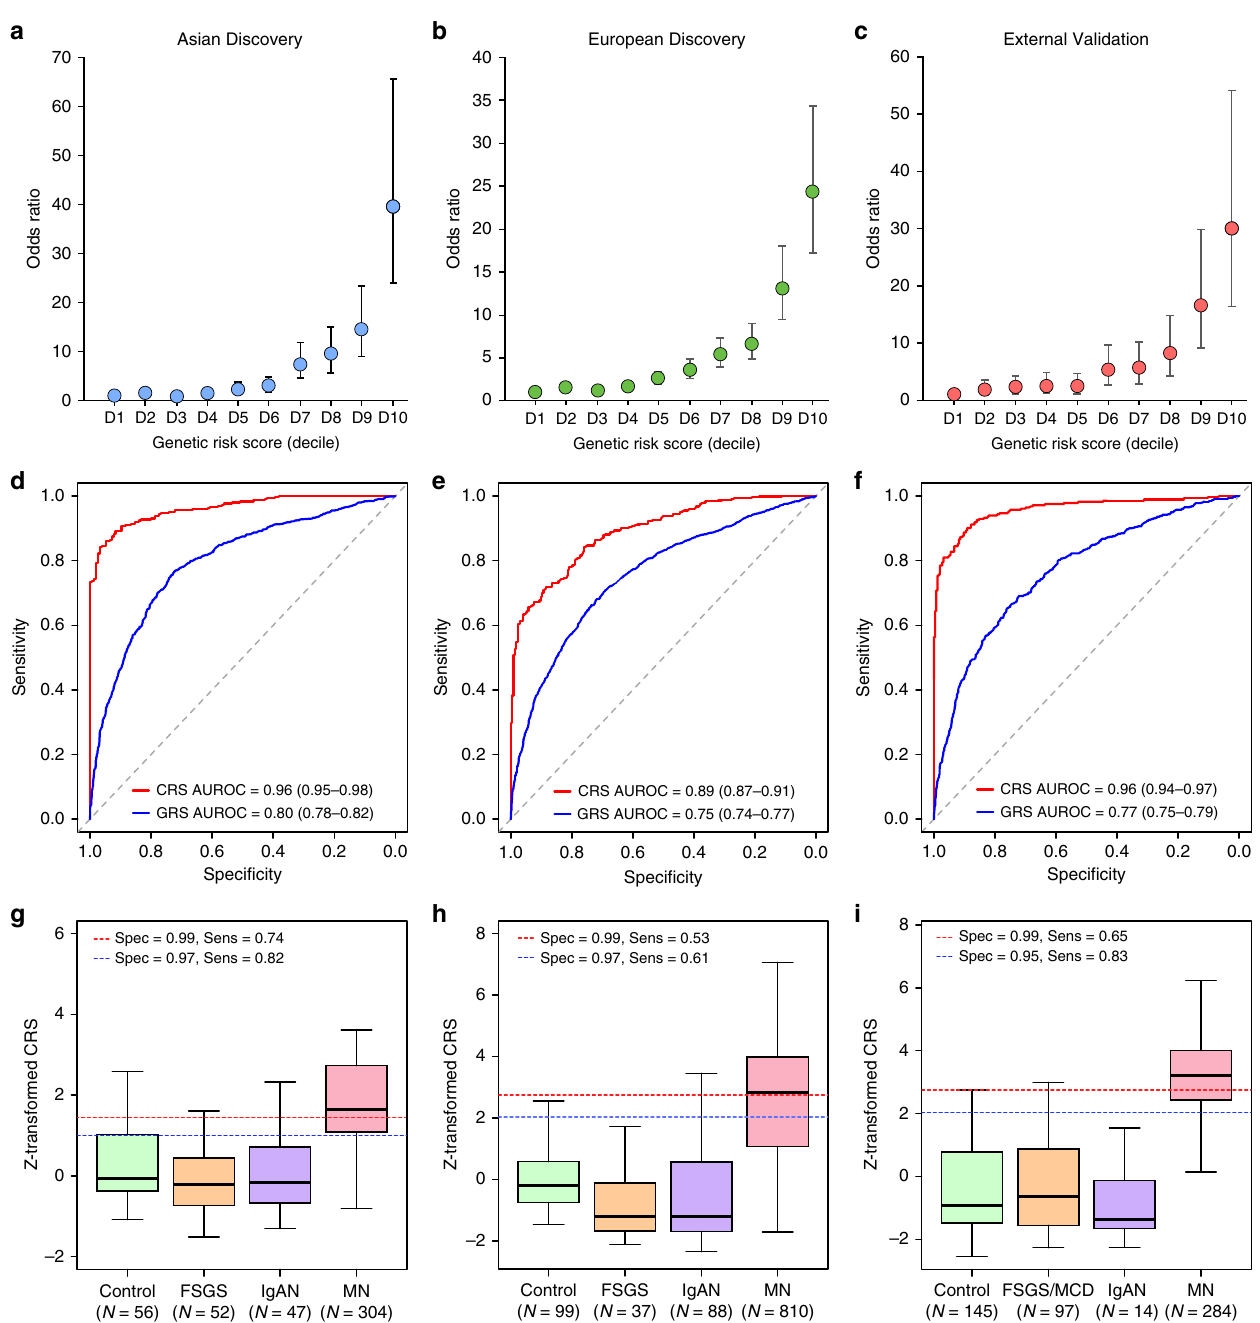
Fig. 6 Diagnostic performance of the genetic risk score (GRS) and the combined risk score (CRS). Genetic effects expressed as odds ratios (OR) and 95% con fi dence intervals in reference to the lowest decile of the GRS distribution for a East Asian discovery, b European discovery, and c European validation cohorts combined. GRS and CRS Receiver Operating Characteristics (ROC) curves for d East Asian discovery, e European discovery, and f European validation cohorts combined; AUROC Area under the ROC curve. Distributions of the CRS between healthy controls, diseased controls, and MN cases for g East Asian discovery, h European discovery, and i European validation cohorts combined. The box plots depict medians (horizontal lines), interquartile ranges (boxes), and minimum/maximum values (whiskers). The discovery CRS cut-offs of 1.00 and 1.45 in East Asians and 2.05 and 2.72 in Europeans have 97% and 99% speci fi city, respectively. The same European cut-offs were applied to the validation cohorts for comparisons of speci fi city and